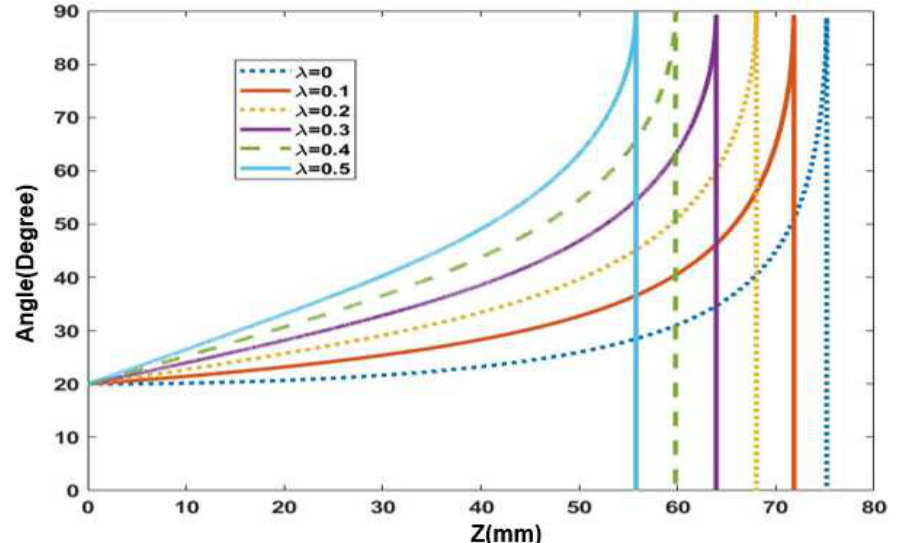
Figure 10. Influence of slippage coefficient on the turnaround radius of the non-geodesic path. By changing its value, turnaround radius of the helical path is changed.